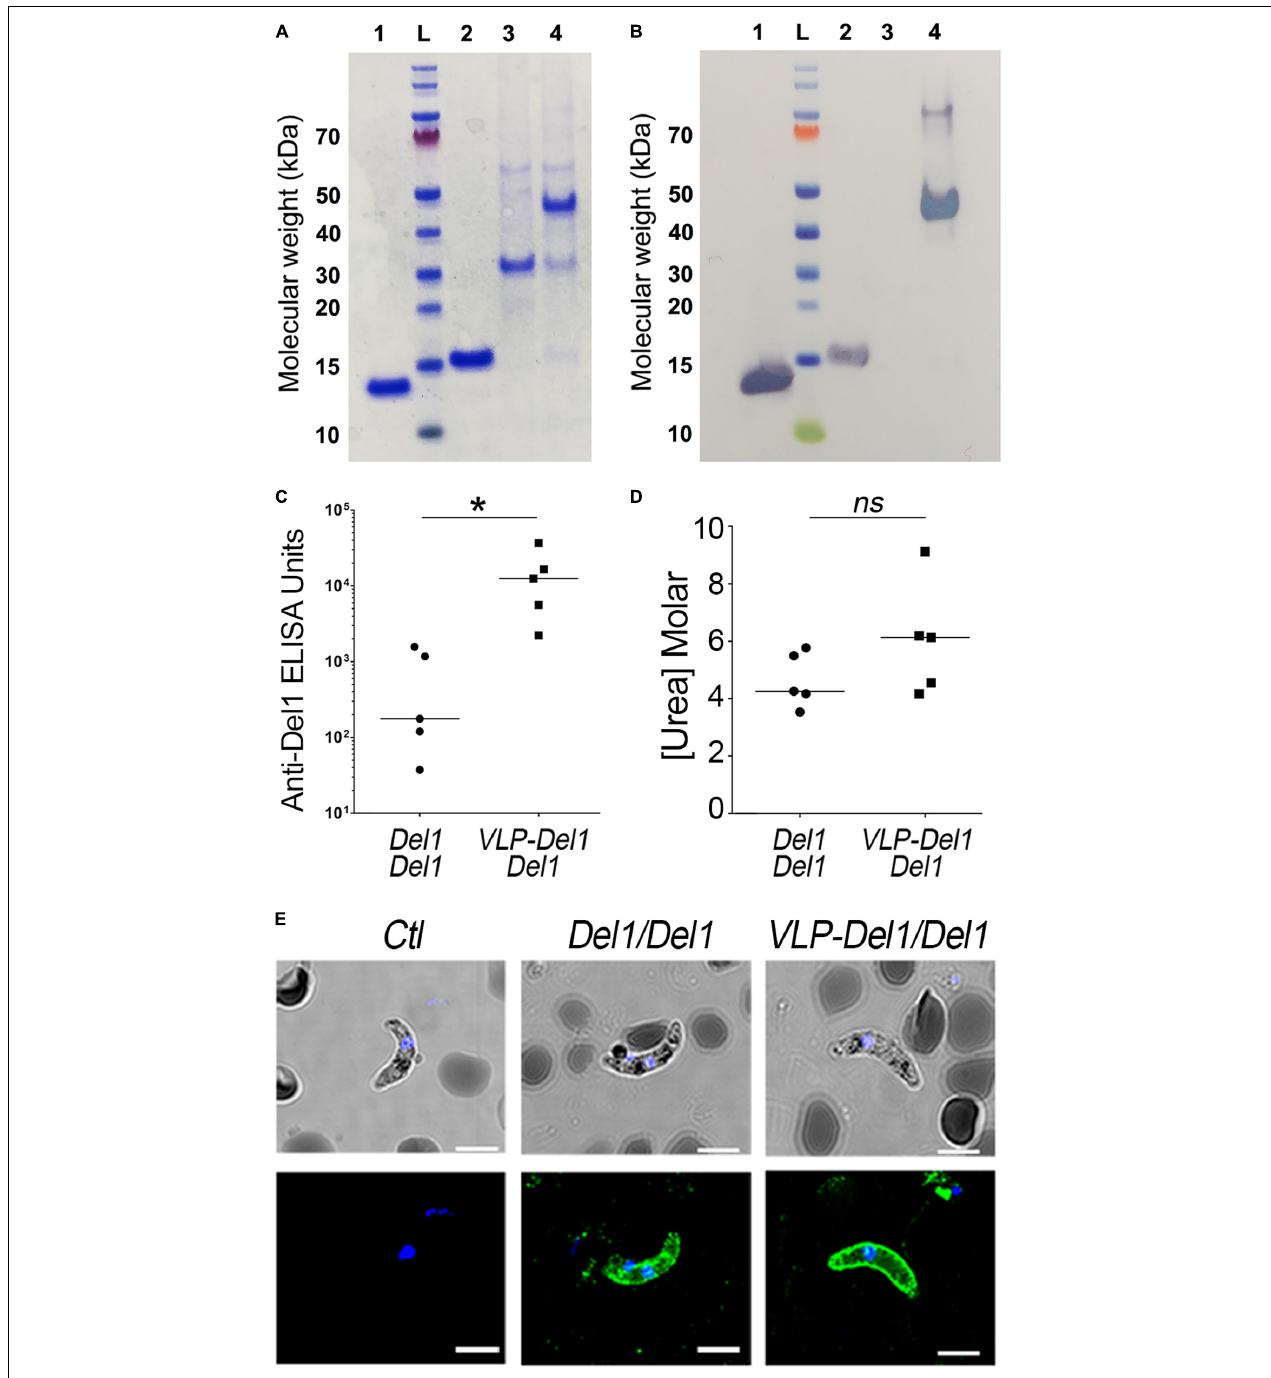
FIGURE 3 | Expression, immunogenicity, and TRA of VLP-Del1. (A) Coomassie blue stained SDS SDS-PAGE and (B) Western Blot showing expression and conjugation of VLP particles. 1. Del1, L. ladder, 2. SpyTag-Del1, 3. SpyCatcher-AP205, 4. VLP-Del1 (C) ELISA showing the reactivity of serum collected from mice immunized intramuscularly with Del1 or VLP-Del1. (D) Antibody avidity was assessed by urea-displacement ELISA. The reduction in OD after incubating each antibody with increasing concentrations of urea (1–8 M) was compared to that after incubation without urea. The binding avidity index is shown, defined as the concentration of urea required to reduce the OD405 to 50% of that without urea (E) Immunofluorescence assay to detect native Pbs47 on Ookinetes. As a negative control, parasites were stained with antibodies from naïve mice (left). Parasites were stained with antibodies derived from mice immunization with Del1 and VPL-Del1 in green. DNA was stained with DAPI (blue); Antibody binding was detected by Alexa Fluor 488-conjugated goat anti-mouse or anti-rabbit IgG. DIC view (top) and a merge of DAPI and antibody staining (bottom) are shown. The staining was imaged using a confocal microscope; Scale bar: 2 µ m. Medians were compared using the t -test: ns, non-significant; * P <